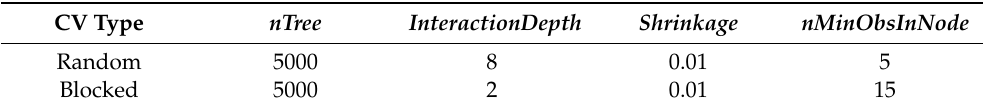
Table 3. Optimal hyperparameters of BRT found by Random and Blocked CV. NTree is the number of trees, nMinObsInNode is the minimum number of observations to consider in one node, shrinkage controls, overfitting and interaction depth control the tree depth.